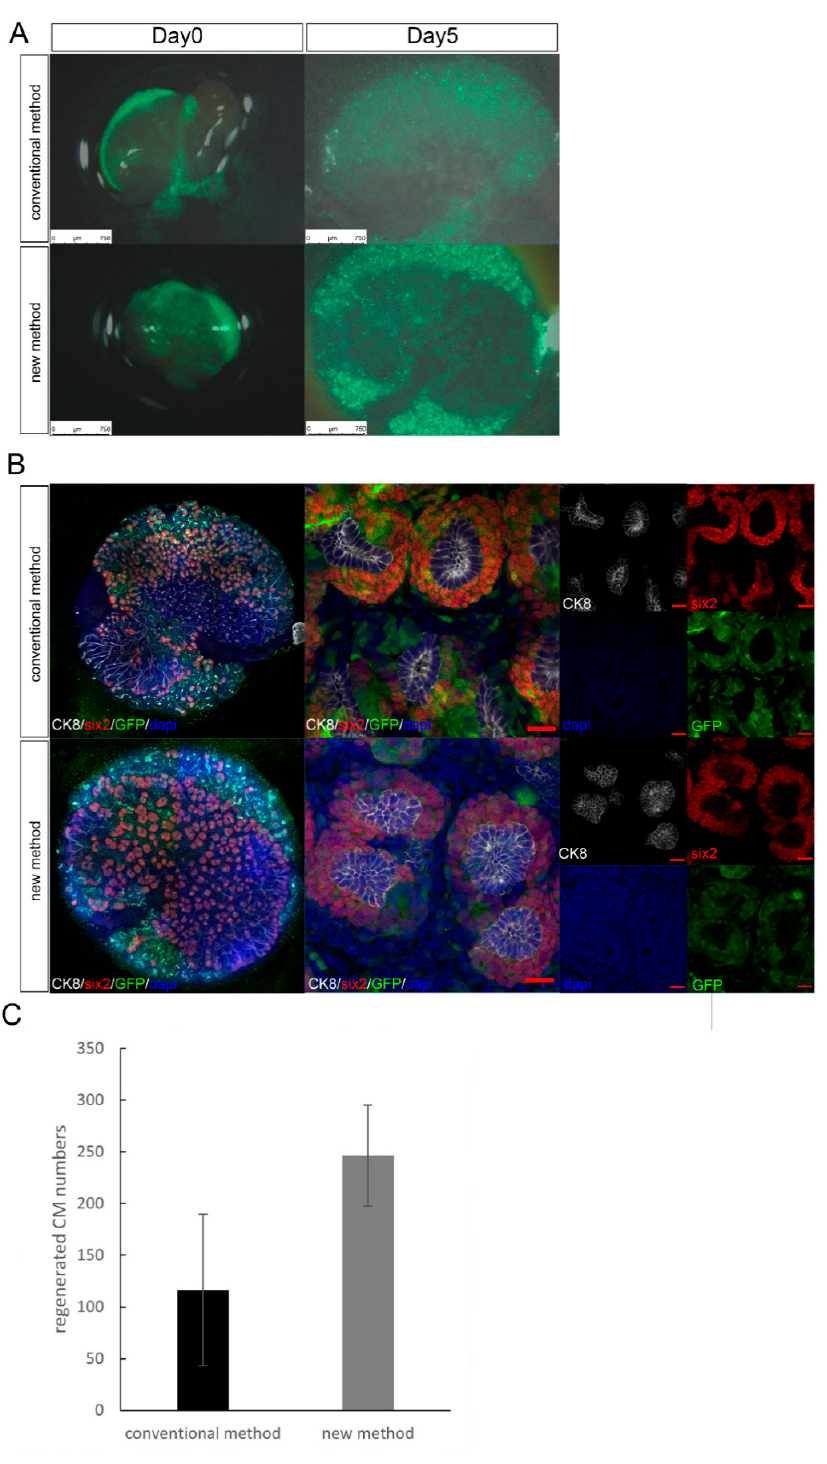
Figure 2. Differences in cell distribution for each cell transplantation method. ( A ) Organ culture of E14.5 Six2-GCE+/diphtheria toxin fragment A+ mouse metanephroi. Mouse green fluorescent protein (GFP) renal progenitor cells were injected into the metanephroi by each method and administrated 4OH-tamoxifen. ( B ) Immunostaining of the metanephroi in ( A ). In the new method, transplanted cell-derived cap mesenchymes (CMs) were distributed practically throughout the metanephros, including the peripheral and central parts of the renal pelvis. (scale bar, 20 μ m). ( C ) Measurement of the transplanted cell-derived CMs. Error bars in bar plots represent standard errors of the mean. DAPI, 4 ′ 6-diamidino-2-phenylindole; CK8, cytokeratin 8.